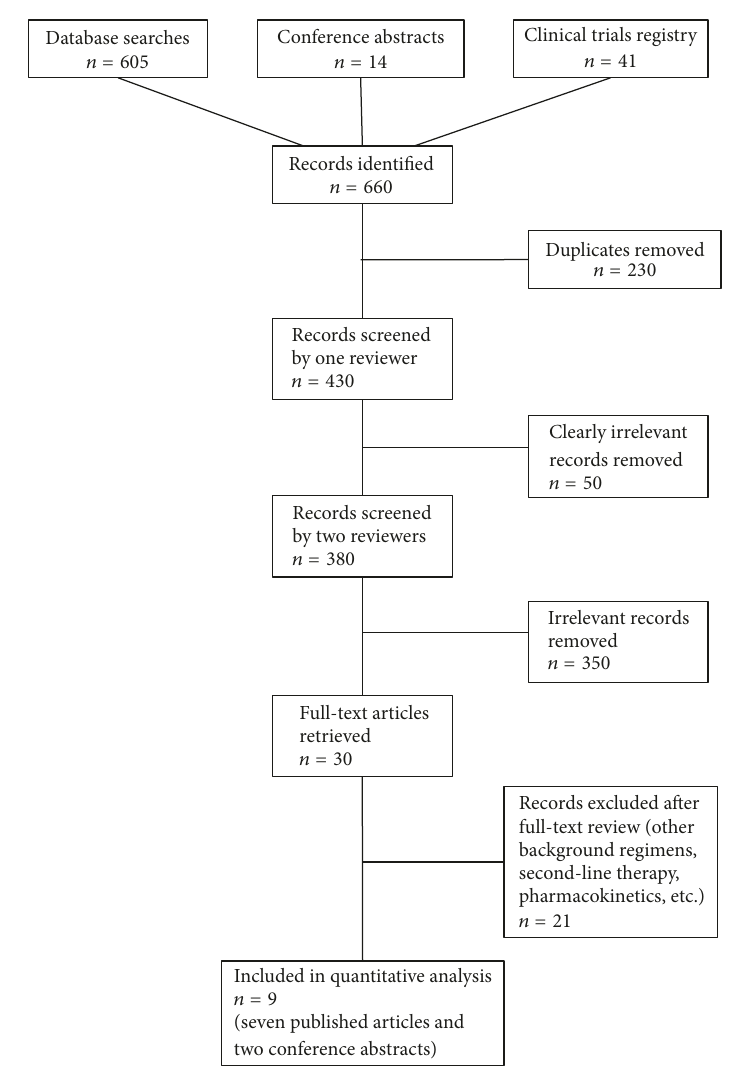
Figure 1: PRISMA